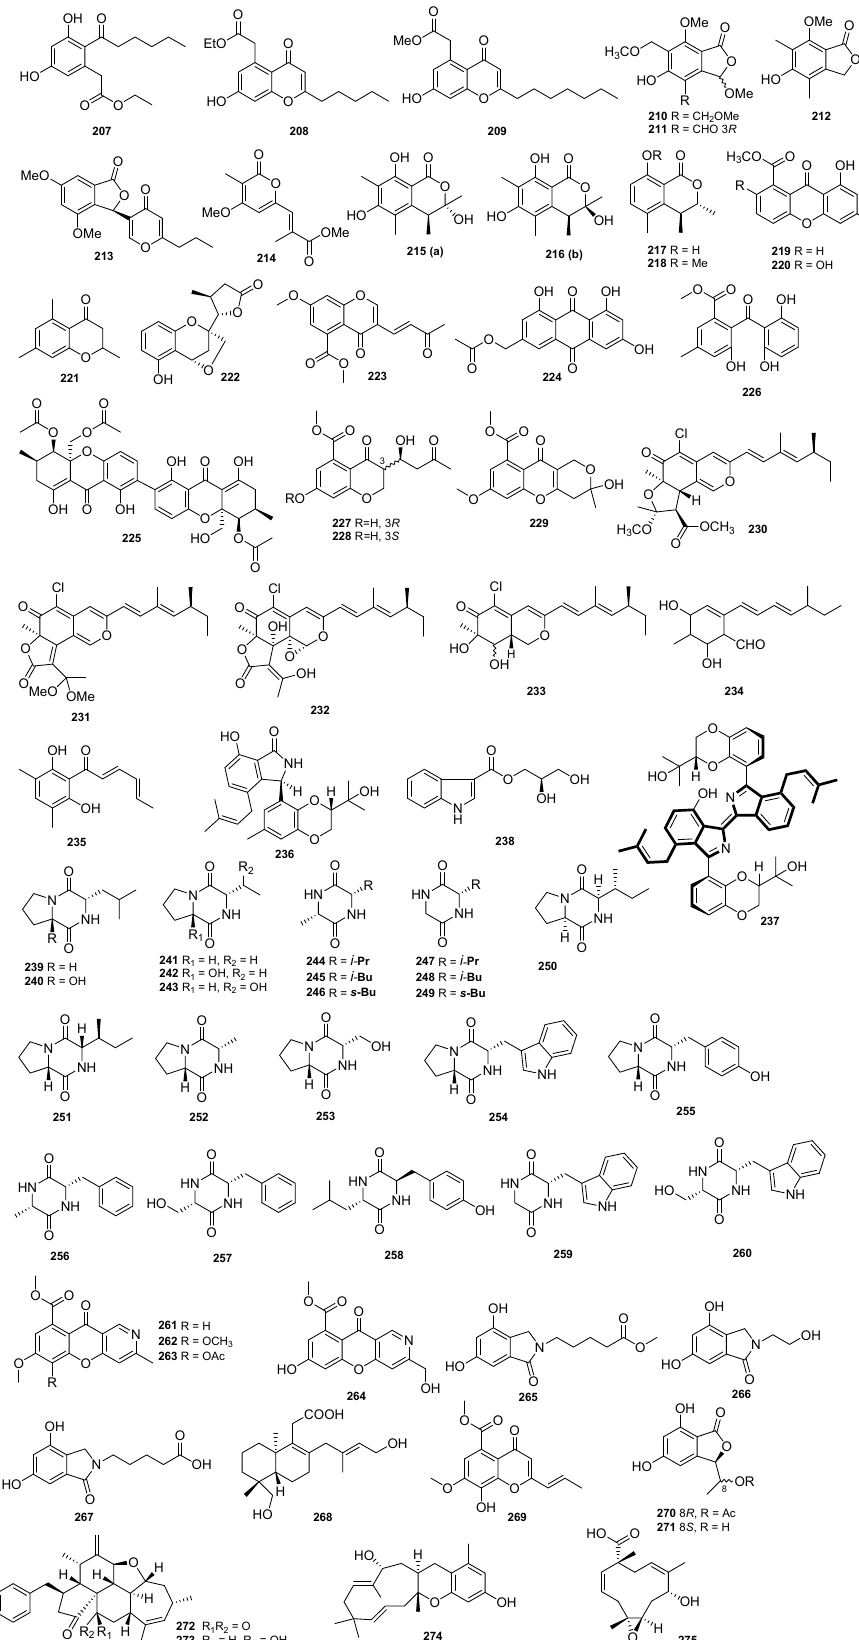
Figure 8. Chemical structures of compounds 207 – 275 of marine origin.